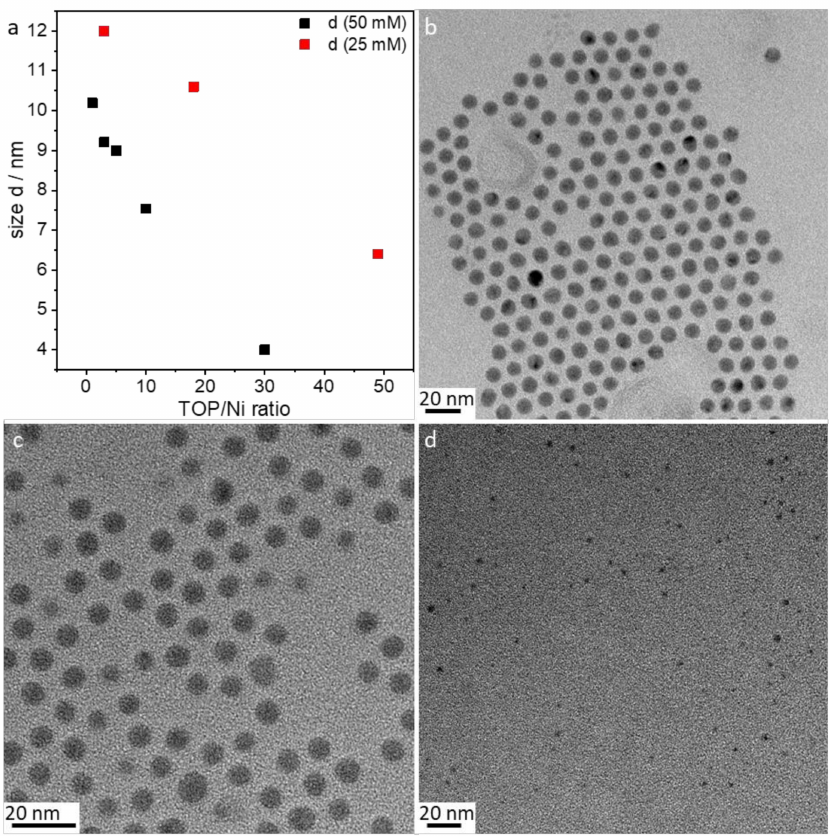
Figure 5. ( a ) Influence of TOP concentration on nanoparticle size: T = 220 ◦ C, t = 2 h; ( b – d ) TEM images of NiNPs formed from 50 mmol / L Ni(acac) 2 with TOP / Ni = 3 ( b ), TOP / Ni = 10 ( c ), and TOP / Ni = 30 ( d ). (v) Long-term stability of the nanoparticles : NiNPs prepared with 50 mmol / L Ni(acac) 2 , TOP / Ni = ◦ 3, and OAm / Ni = 61 for 2 h at 220 C were investigated using STEM and EDS. Figure 6 shows the distribution of elements (line scan indicated by blue line, K-lines) of nickel and oxygen on the nanoparticles two weeks after synthesis (Figure 6a) and after nine weeks of storage (Figure 6b) on the TEM grid. The expected distribution of nickel within the NiNPs is aligned with the contrast di ff erences in the STEM image. Due to the lower local concentration after synthesis, the oxygen distribution around the nanoparticles demonstrates the ongoing oxidation process on the particle surface by showing higher intensities at the outer regions of the particles and less intensity at the inner regions of the particles. The overall atomic fraction of nickel in the particles decreases over time, indicated by a maximum amount of 100 mol / mol in the fresh nanoparticles in comparison to a maximum of 80 mol / mol in the altered particles. The carbon distribution is not analyzed in the line scan, as it shows strong intensities around the particles assignable to the lacey carbon film on the used copper TEM grid, but it is shown in the mapping image (Figure 7 left). The phosphorus distribution confirms the presence of stabilizer TOP on the particle surface leading to well-separated and organized